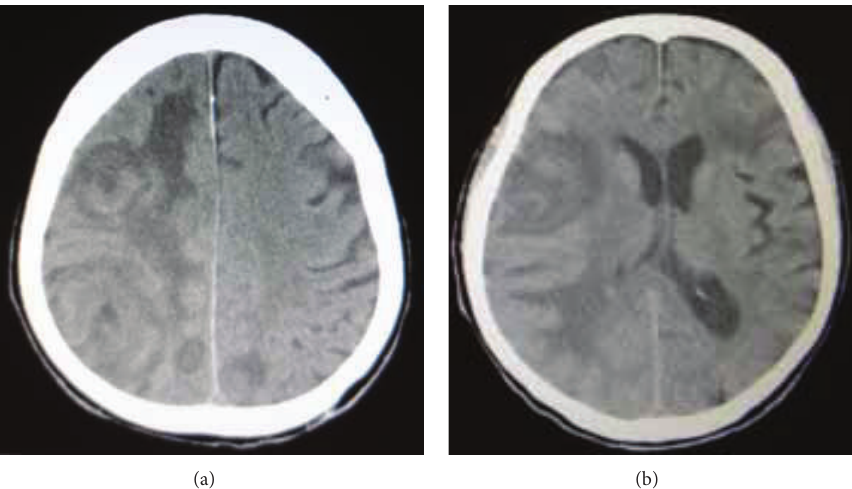
Figure 5: Following surgical operation and radiation therapy, computed tomography (CT) showed a large recurrent tumor with perifocal edema in the right frontal lobe (a)